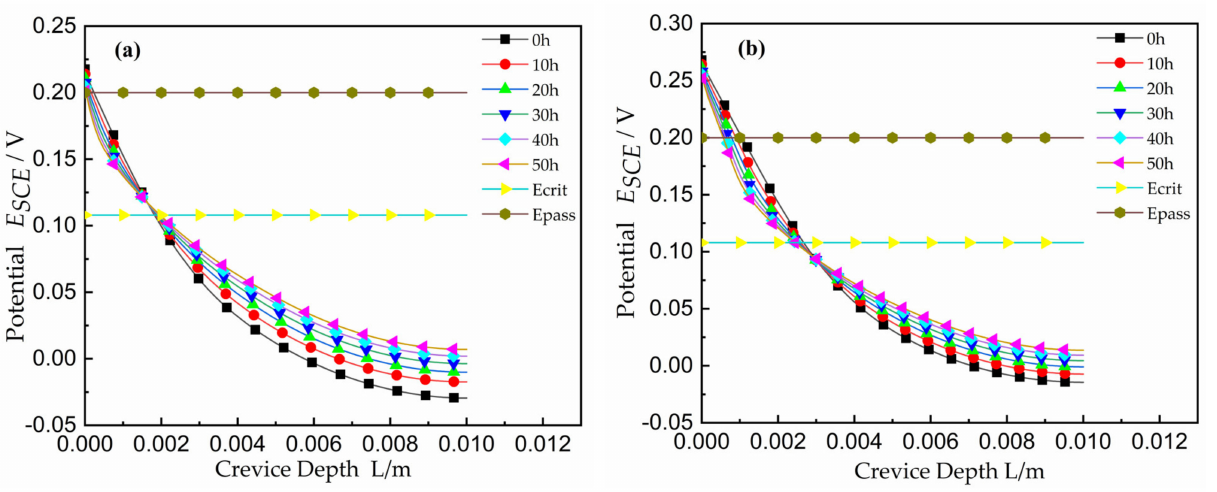
Figure 6. Curves of potential versus depth for the width W = 0.3 mm at various times: ( a ) the applied potential E A = 0.25 V; ( b ) the applied potential E A = 0.30